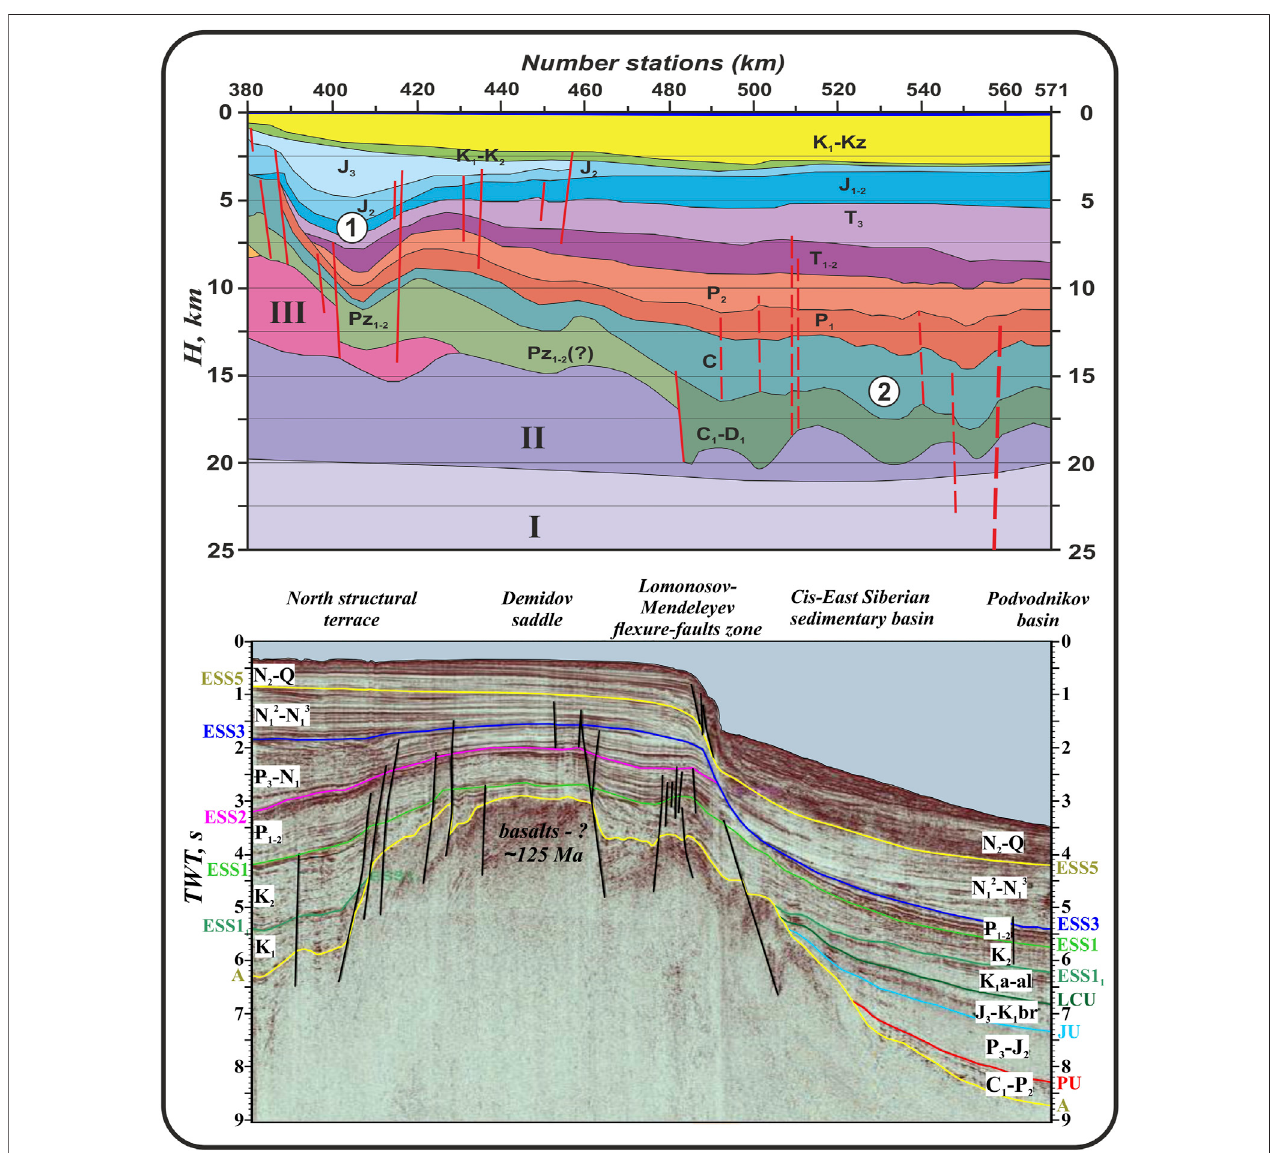
FIGURE 2 | Geoseismic pro fi les of the East Siberian Sea: (A) 5AR — after Sakulina et al. (2011). Geostructures are as follows: 1) Kolyuchinsky graben-rift and 2) North Chukchi Depression. Pre-Paleozoic formations are (I) basite layer of the lower crust, II) diorite layer of the upper crust, and III) Archean – Upper Proterozoic granite- metamorphic layer of the upper crust. Red lines — known faults (solid) and assumed (discontinuous). (B) MAGE2016 — after Kazanin et al. (2017a). Colored lines — re fl ectors of geoseismic rock associations and black lines — faults.